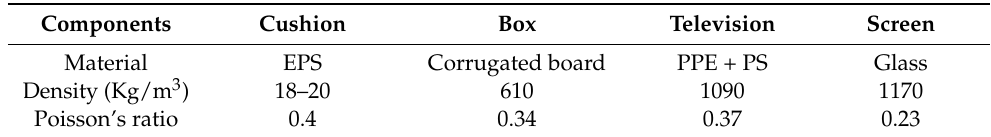
Table 4. Material properties for